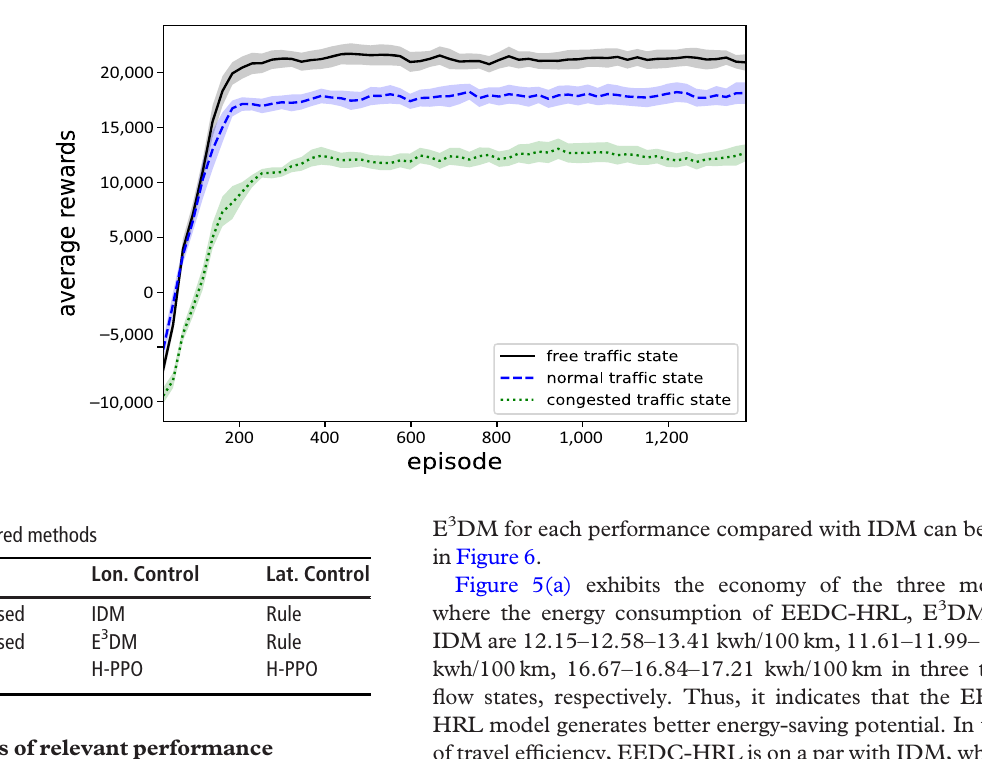
Figure 4 Training performance of H-PPO in three traf fi c states